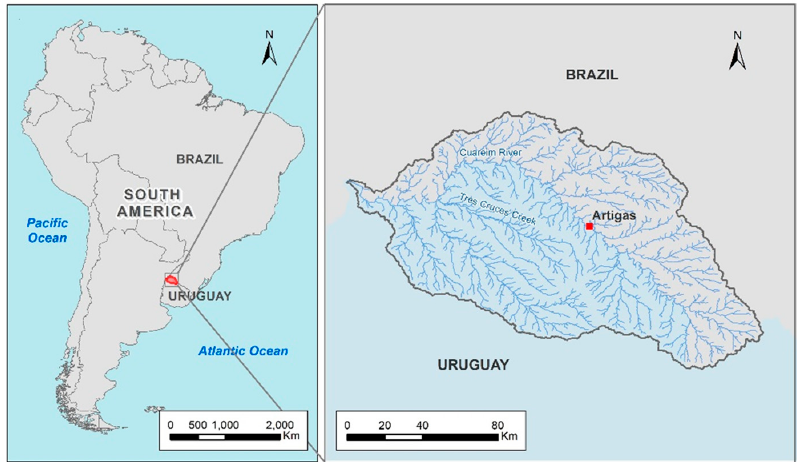
/ Quara í transboundary Figure 2. Cuareim/Quaraí transboundary watershed. Figure 2. Cuareim